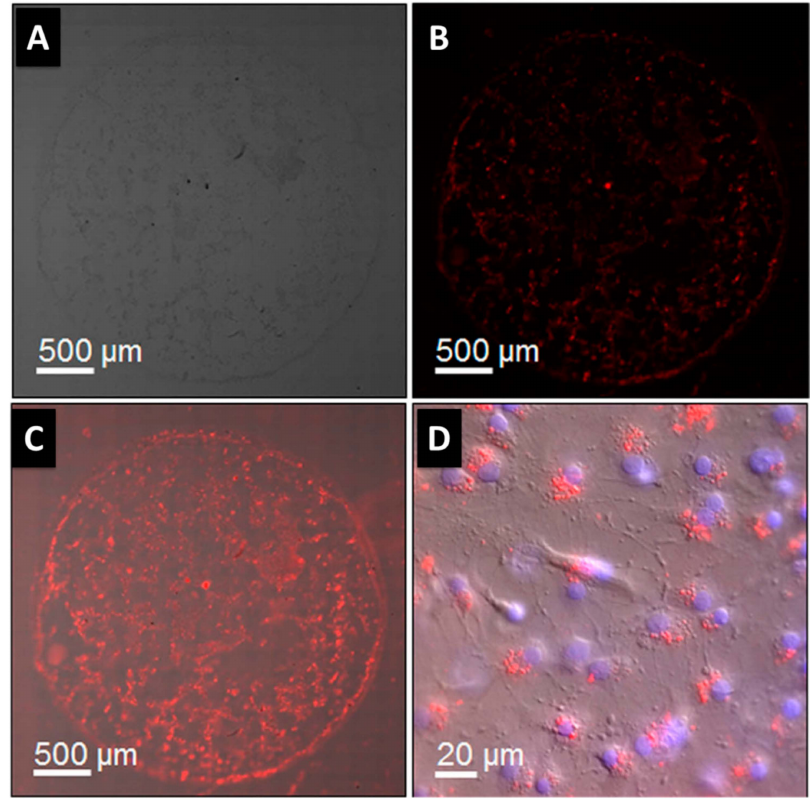
Figure 9. ( A ) Bright-field picture showing all cells; ( B ) red fluorescence image revealing QD in nanoparticles, which are specifically localized using a Rhodamine filter; ( C ) merged image; ( D ) mag- nification of ( C ) showing few individual cells. Hoechst staining marks cell nuclei blue. Nanoparticles (red dots) near nuclei indicate cell localization